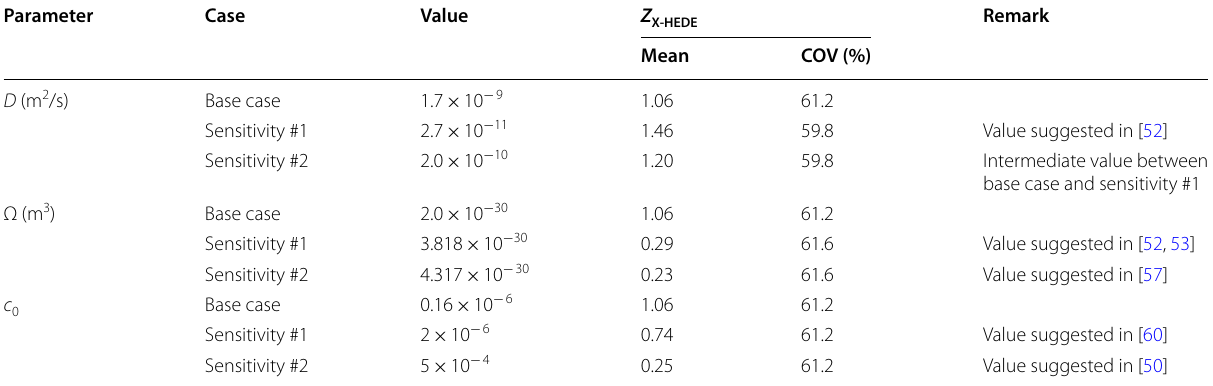
Table 6 Sensitivity analyses with respect to three parameters in the HEDE component of Xing et al.’s model Parameter Case